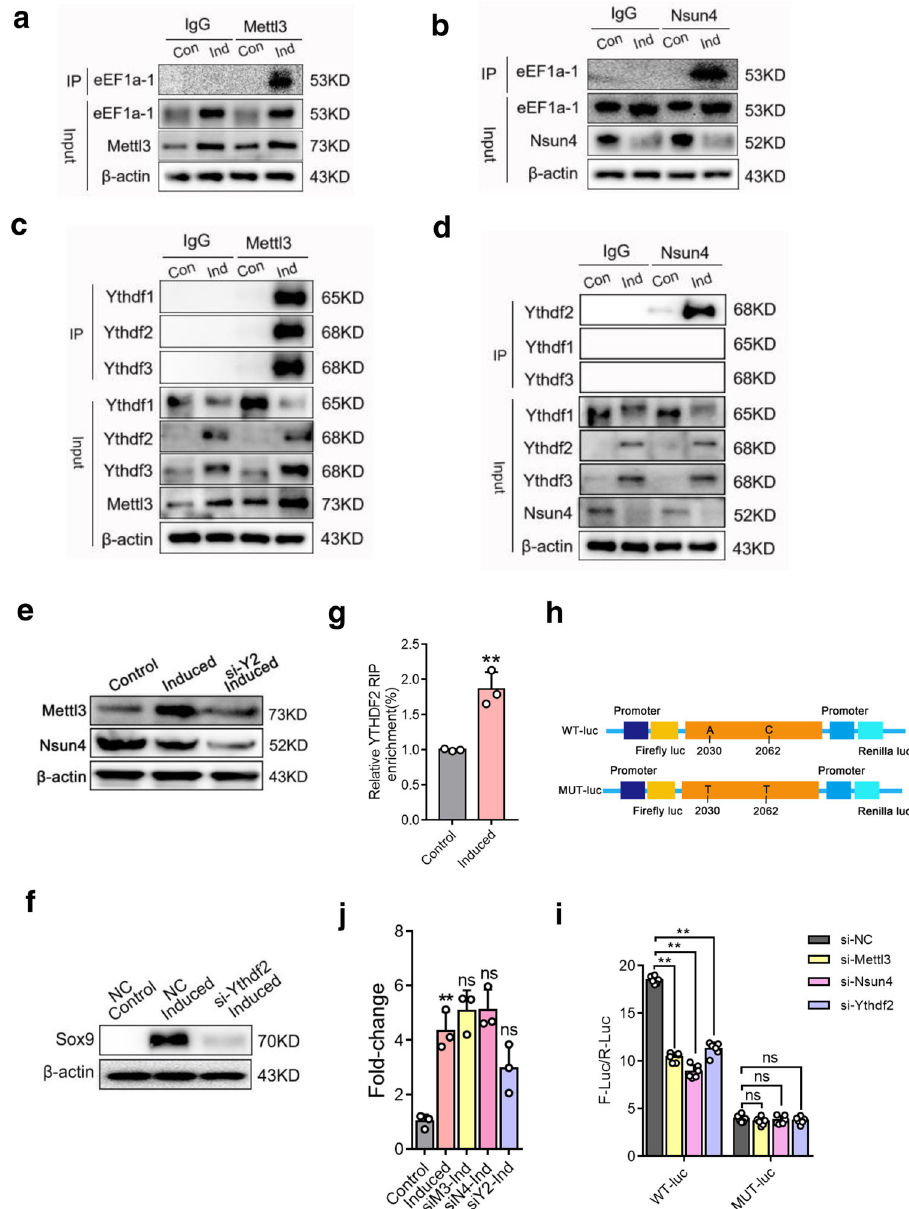
Fig. 4 Nsun4 and Mettl3 regulate translational reprograming of Sox9 through NMYE complex assembly. a , b Proteins were immunoprecipitated with Nsun4 a or Mettl3 b antibody from BMSCs with or without on chondrogenic differentiation; eEF1a-1 was detected with the indicated antibody. c , d Binding between Mettl3 c or Nsun4 d with YTHDF1-3 in control and induced cells were checked by immunoprecipitation; YTHDF2 was speci fi cally recognized. e , f BMSCs were cultured in chondrogenic induce medium for 7 days after transfected with or without si-YTHDF2 for 24 h, the protein expression of Mettl3, Nsun4 e and Sox9 f was detected by western blot analysis. β -actin is used as a loading control. g YTHDF2 RIP-qPCR analysis of SOX9 mRNA in 3 ’ UTR in the control and BMSCs undergoing chondrogenic differentiation. h Schematic diagram of Sox9 3 ’ UTR wide type (WT-luc) and mutant type (MUT- luc) reporters. The 300-nt DNA sequence of the WT Sox9 3 ’ UTR segment sequence was inserted to the dual-luciferase reporter plasmid to give rise to the WT-luc reporter. For the MUT-luc, A and C to T substitutions were made. i Relative dual-luciferase reporter activity of WT-luc (left) and Mut-luc (right) reporter in 293 T cells with ectopically expressed Mettl3, Nsun4 and Ythdf2 respectively. j BMSCs were transfected with or without siRNAs for 24 h, then cultured in chondrogenic induce medium; Sox9 mRNA was analyzed by RT-qPCR. Data are presented as means± SD from three or six independent experiment. Student ’ s t test were performed for ( g ). One way ANOVA and Tukey ’ s multiple comparison tests were performed for ( j , i ). ** p < 0.01 compared with the control group or NC group; ns, no signi fi cant. NMYE, Nsun4, Mettl3, Ythdf2,